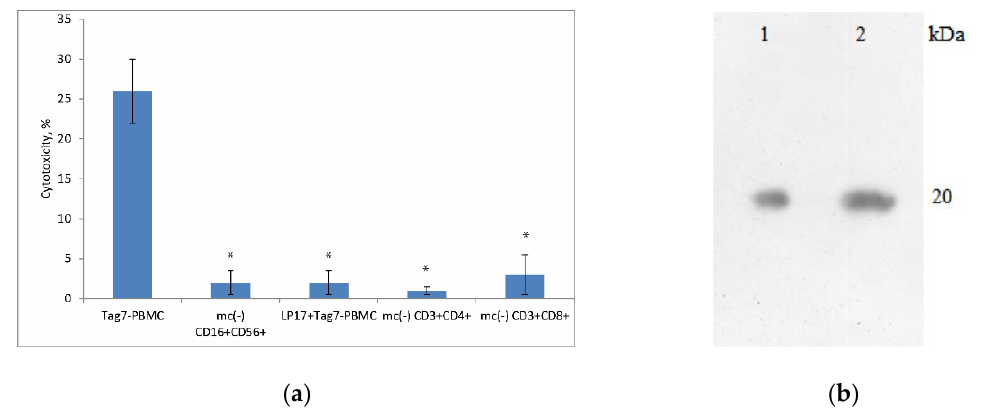
Figure 1. Monocytes are necessary for the induction of cytotoxic lymphocyte subpopulations by Tag7. ( a ) PBMCs were depleted of monocytes (mc–) and treated with Tag7 for 4 days (for CD16 + CD56 + cells) or 6 days (for CD3 + CD4 + and CD3 + CD8 + cells). These lymphocyte subpopulations were isolated by magnetic cell separation and tested for cytotoxicity against K562 cells. The peripheral blood mononuclear cell (PBMC) pool was treated with Tag7 for 6 days in the presence of peptide LP17 (1nM) TREM-1 inhibitor (added 1 h prior to treatment), and then cytotoxic activity against K562 cells was measured. Data are presented as the mean ± SD of 3 independent experiments. Error bars represent SD between triplicates. Di ff erences from the control in all cases are significant at * p < 0.05 (Student t test). ( b ) Tag7, applied to the TREM-1 conjugated Sepharose column and then eluted and detected by WB (1). WB of Tag7 (20kDa) was used as a control (2). Anti-Tag7 rabbit antibodies, with anti-rabbit antibodies conjugated to peroxidase subsequently, were used for staining.